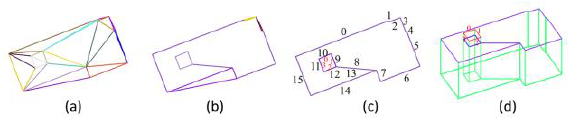
Fig. 3. Example of the TIN-Merging